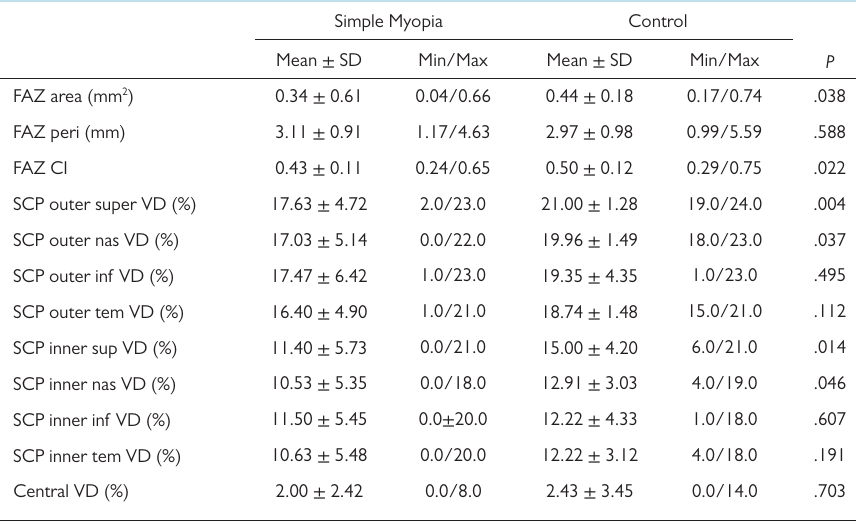
Table 4. OCTA Findings of the Study Participants Simple Myopia Control